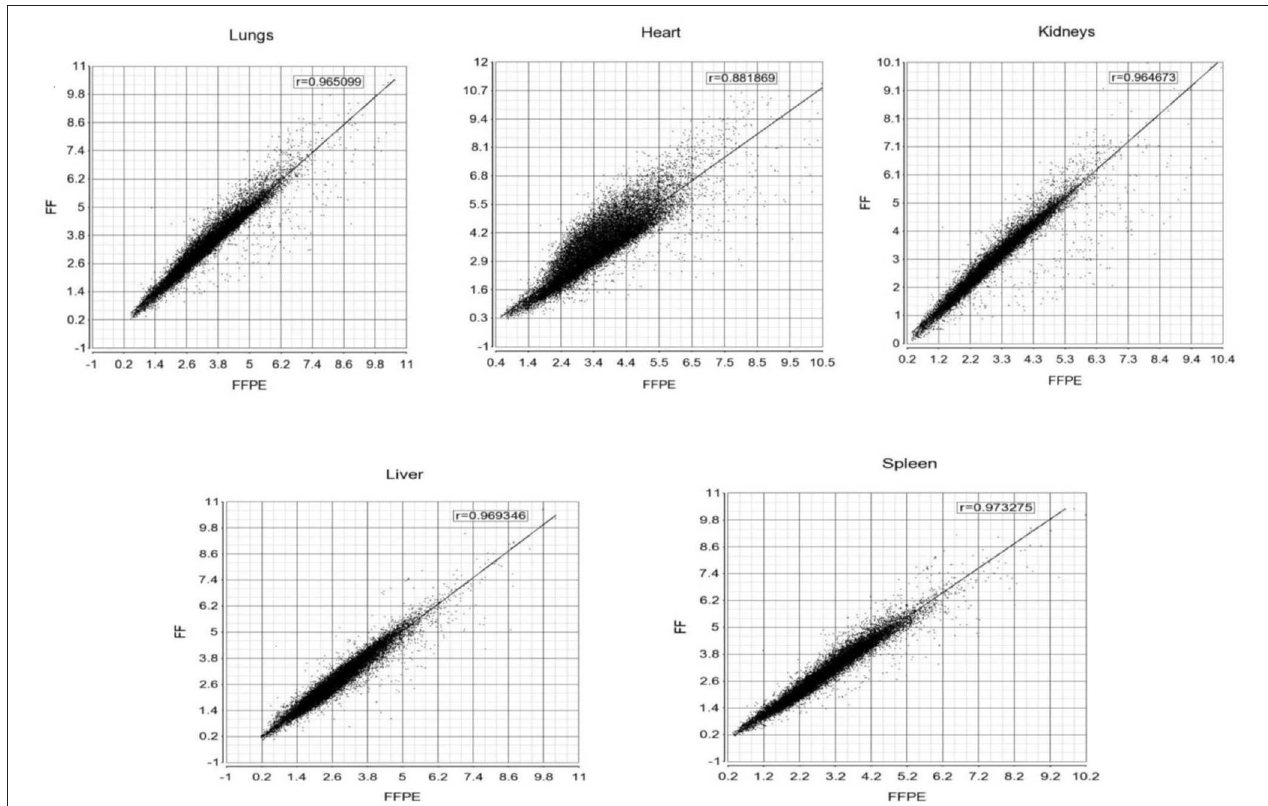
FIGURE 1 | Correlation plots of the gene expression profiles between FF and FFPE tissue samples from meningococcal septic shock patients. The mean signal intensities for unfiltered gene expression (25000 transcripts) with NM (m-RNA) and NR (ncRNA) annotations on FF (x-axis) and FFPE (Y-axis) tissue samples for respectively lungs, heart, kidneys, liver and spleen. Pearson correlation coefficients (r) for each scatter plot are shown on the